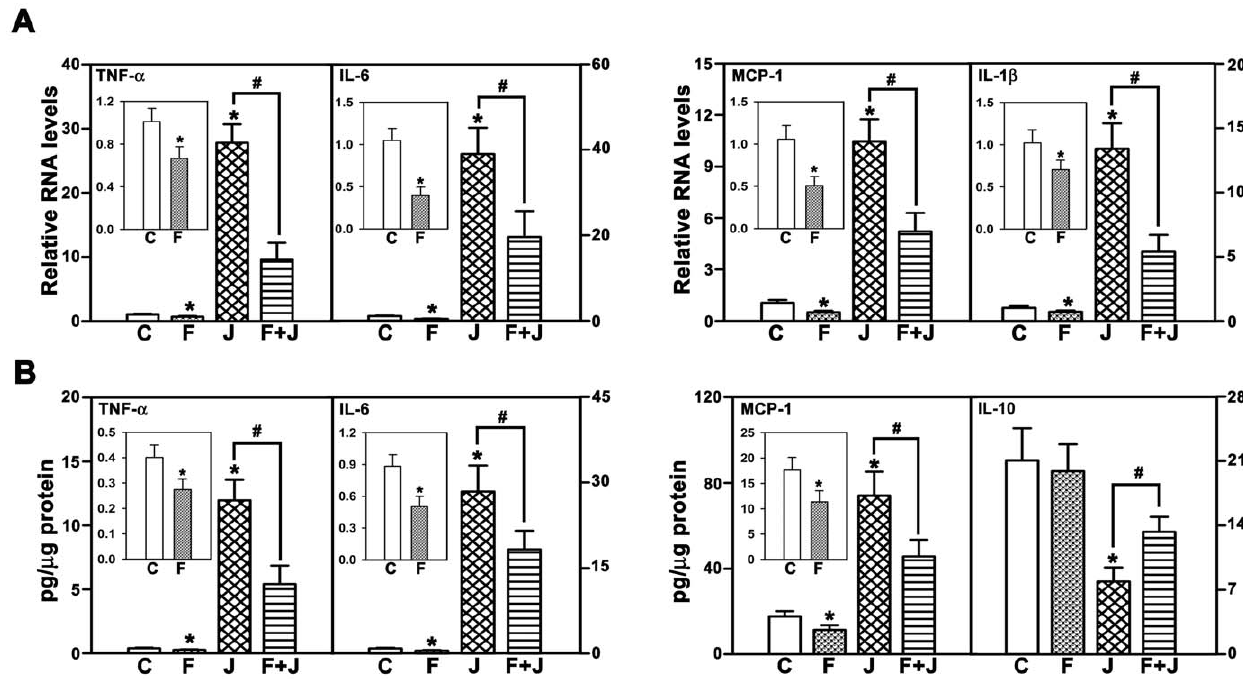
Figure 4. Fenofibrate attenuates the massive inflammatory response seen in JEV infection. The inflammatory response to JEV challenge was attenuated by fenofibrate as depicted by significant reduction in mRNA expression (A) and protein levels (B) of cytokines (TNF- a , IL-6, IL-1 b ) and chemokine (MCP-1) compared to JEV alone. Conversely, protective cytokine IL-10 (B) production was increased in fenofibrate treated mice compared to JEV alone. Insets in A,B show the decrease in cytokines and chemokine after fenofibrate treatment alone. Data is represented as (C) vehicle control, (F) fenofibrate, (J) JEV, (F + J) fenofibrate + JEV treated mouse brain cortex. mRNA levels in A,B for all treatments are expressed relative to controls (n=6 per group, *and # p ,